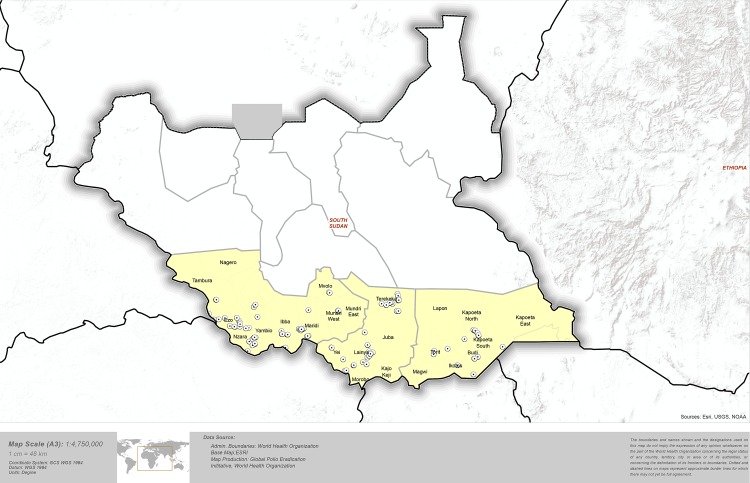
Map of South Sudan with dots representing households mapped during supervision activities*.* 49.0% of households had GPS co-ordinates recorded.